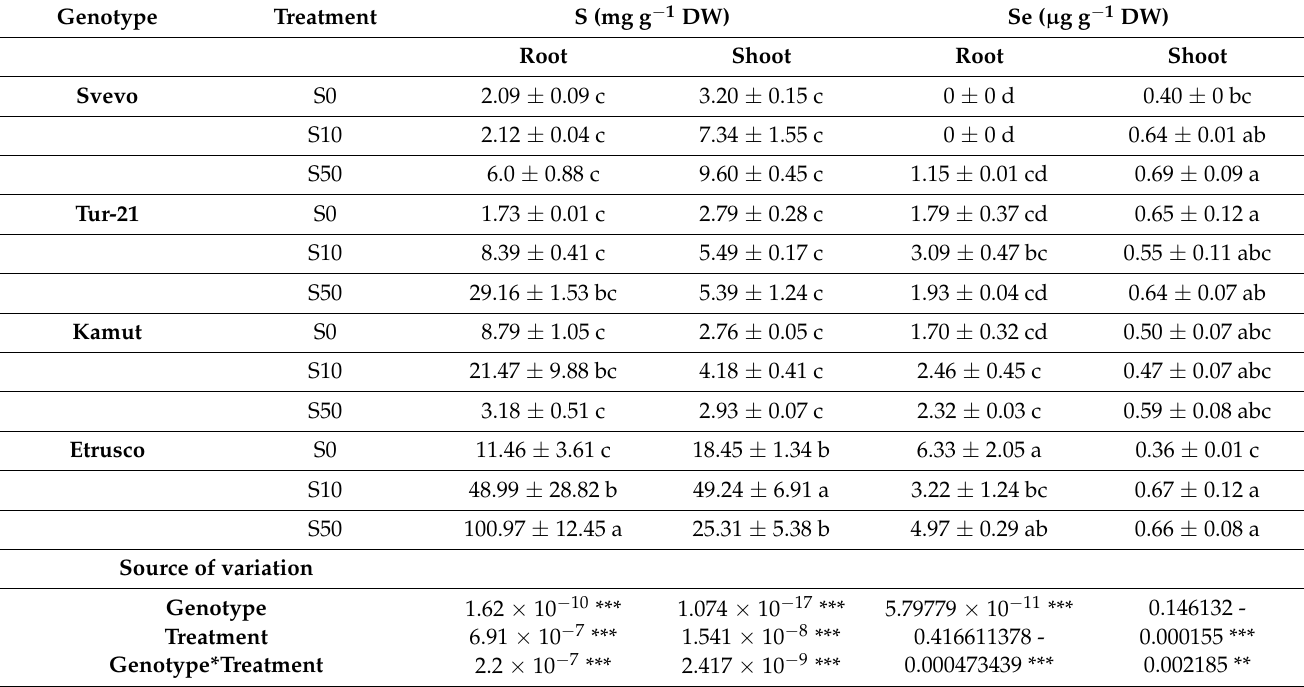
Table 1. Root and shoot sulfur and selenium concentrations of four wheat genotypes (Svevo, Tur-21, Kamut, and Etrusco) grown with sufficient (S) availability of sulfate.